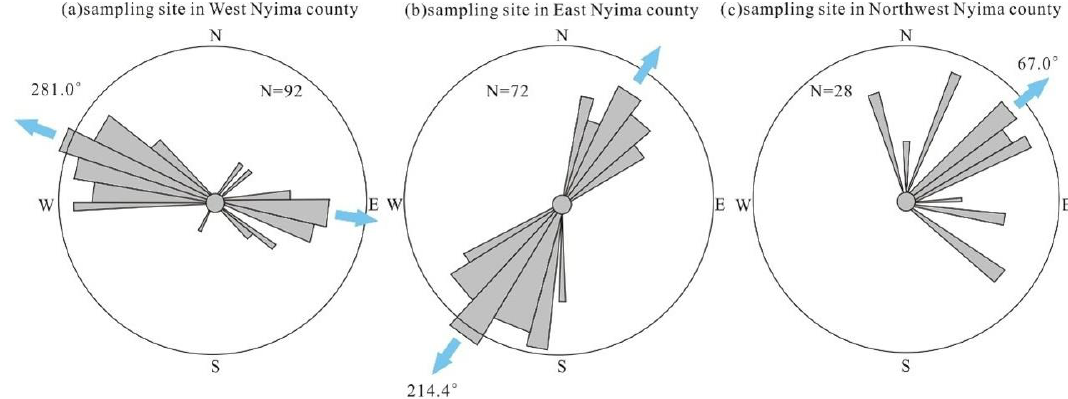
Figure 11. Paleocurrent in rose diagram at different sampling points in the Nyima